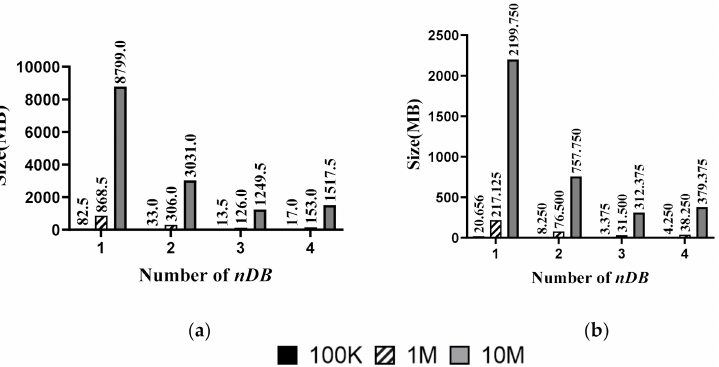
Figure 10. Comparison of the size of the result ciphertexts: ( a ) size of database ciphertexts; ( b ) size of result